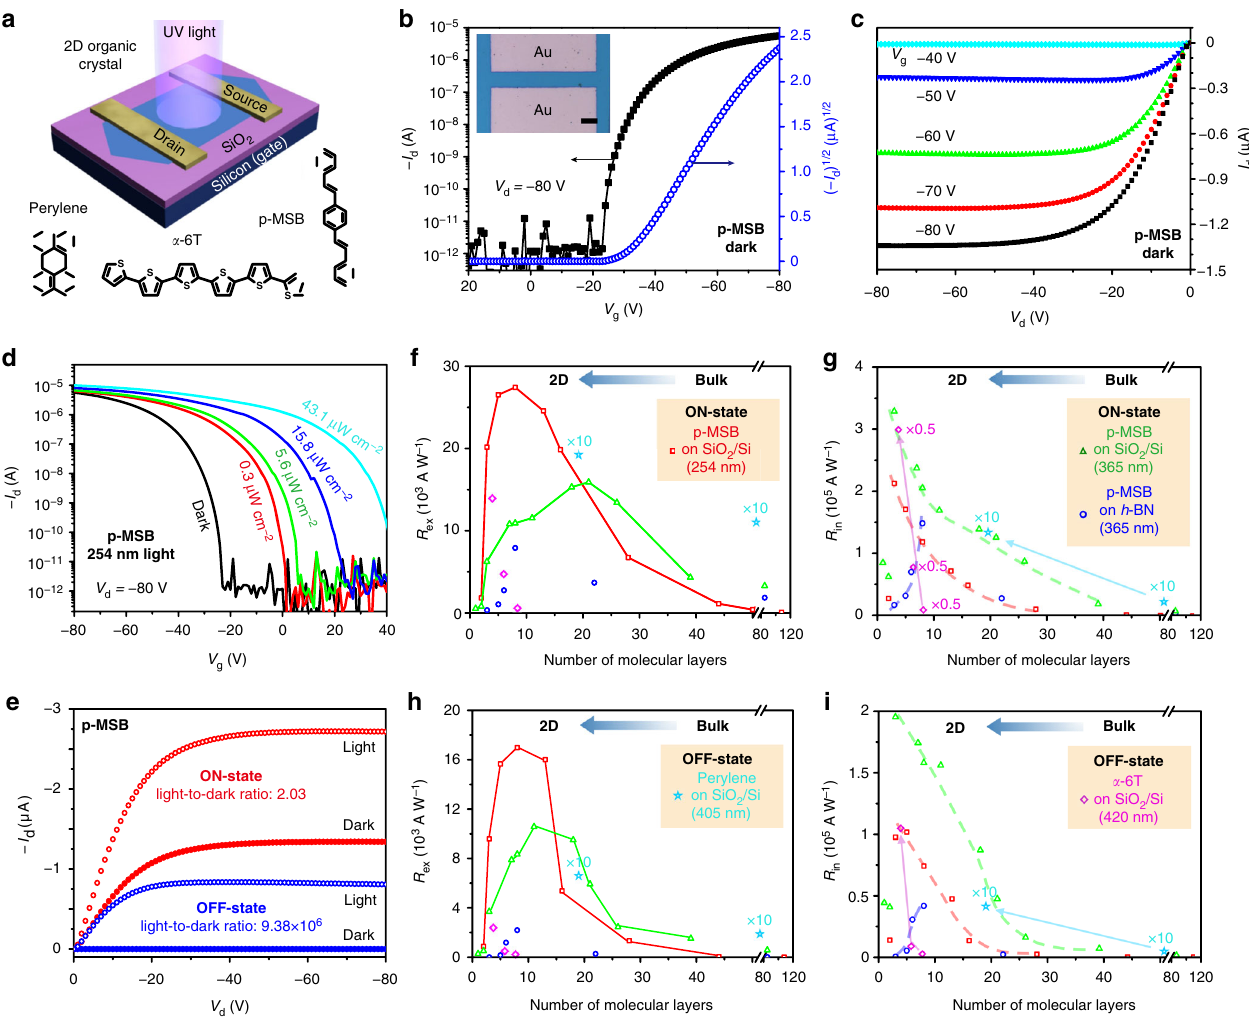
Fig. 4 Electrical and photoelectrical characteristics of the crystals. a Bird ’ s-eye view of a schematic con fi guration of the photodetector based on a 2D organic crystal, and the molecular structures of p-MSB, perylene, and α -6T. b Transfer (drain current ( I d ) vs. gate voltage ( V g ), when drain voltage ( V d ) is − 80 V) and c output ( I V d vs. d ) curves of a typical 2D p-MSB device. The inset of b is the optical microscopy image of a 2D p-MSB device. d Transfer curves of the device ( V d = − 80 V) in the dark or under 254-nm illumination with different power intensities. e On-state ( V g = − 80 V) and off-state ( V g = − 20 V) I V μ W cm − 2 ). f , h External photoresponsivity ( R d versus d curves of the p-MSB device in the dark or under 254-nm illumination (43.1 ex ) and g , i , internal photoresponsivity ( R in ) as a function of the number of molecular layers (p-MSB, perylene, or α -6T) under illumination (12.5 μ W cm − 2 254 nm, 14.1 μ W cm − 2 365 nm, 112 μ W cm − 2 405 nm, and 141 μ W cm − 2 420 nm) when the devices operate in the ON-state ( f , g ) or OFF-state ( h , i ). The dashed lines in g and i indicate different 2D limit effects on the R in when the crystal is located on different substrates (SiO 2 /Si or h -BN). The scale bar in b is 20 μ